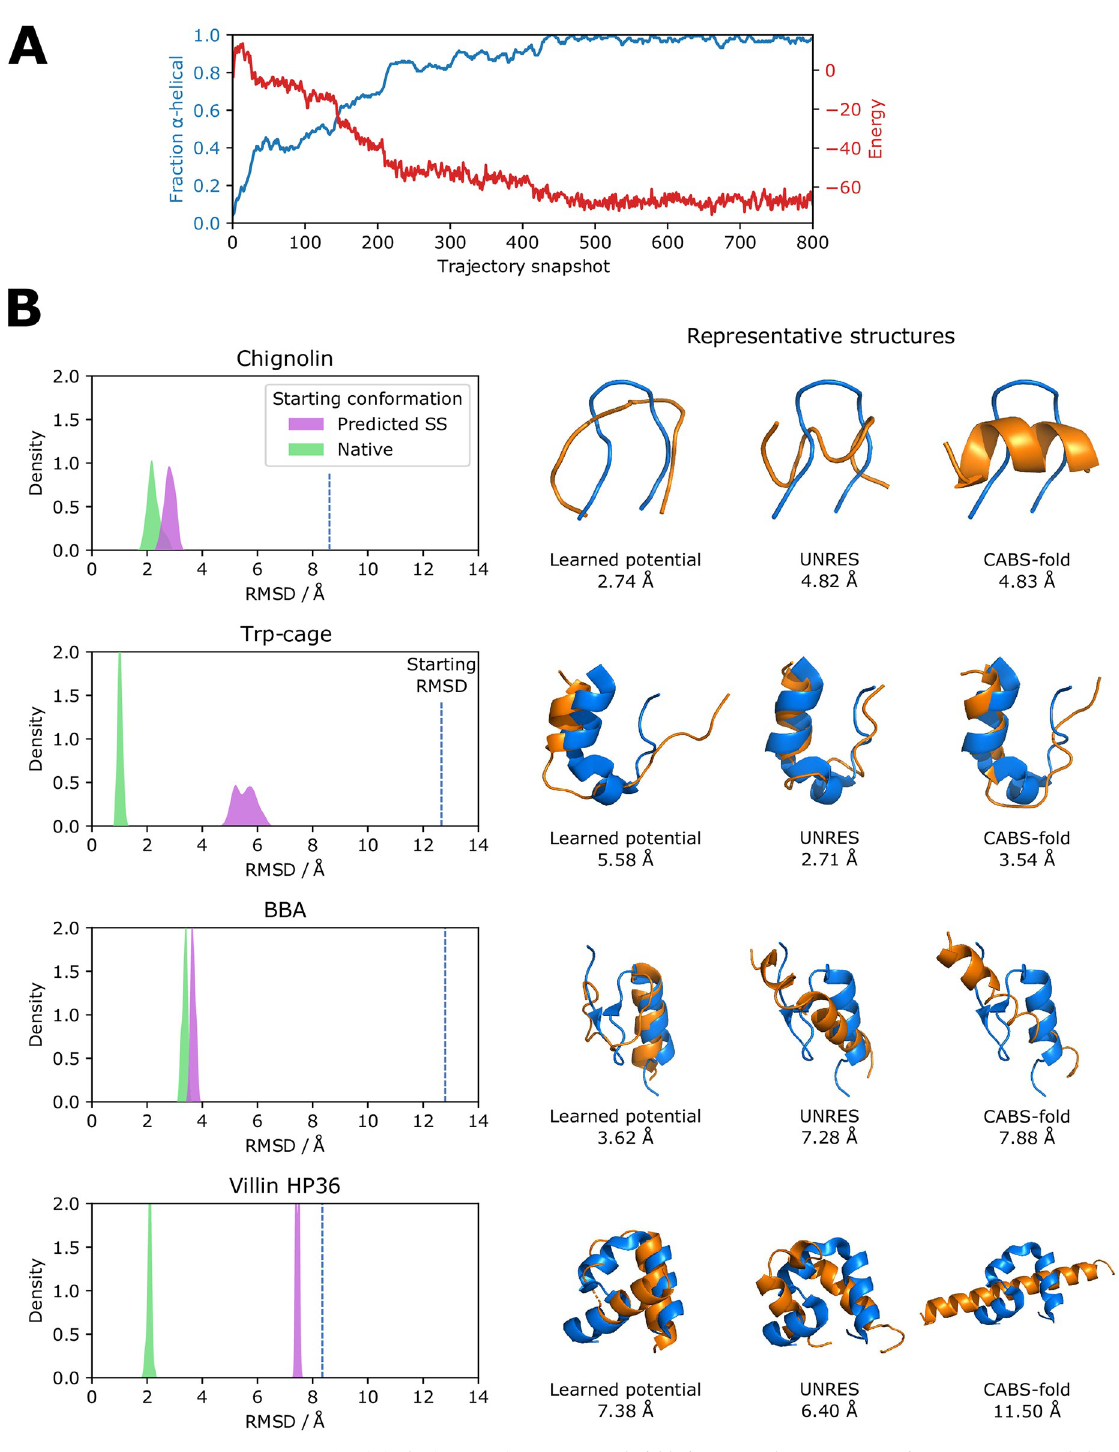
Fig 4. Folding small proteins and peptides. (A) The (AAQAA) 3 repeat peptide folds from a random starting conformation into an α -helix over 12m steps. The α -helical fraction and energy in the learned potential are shown with a snapshot taken every 15,000 steps. (B) C α RMSD distributions from simulations of 3m steps for 4 proteins starting from predicted secondary structure and native conformations. An initial burn-in period of 9m steps was discarded. The starting C α RMSD for the predicted secondary structure conformation is also shown. A representative structure found with MDAnalysis is shown (orange) along with models generated from the web servers of UNRES and CABS- fold. The C α RMSD to the native structure (blue) is given for each model.